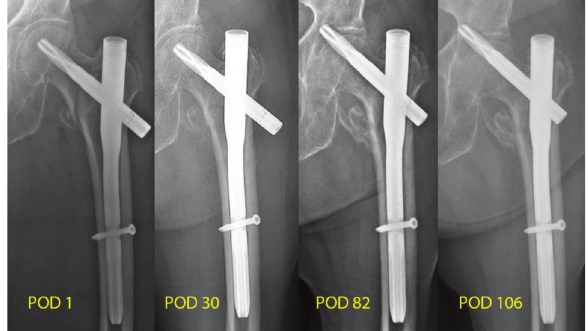
Serial radiographs showing initial FNE lateral migration Fig. 10: with fracture impaction and subsequent paradoxical migration of the FNE superomedially against gravity with resultant femoral head perforation and acetabulum penetration in the medial migration